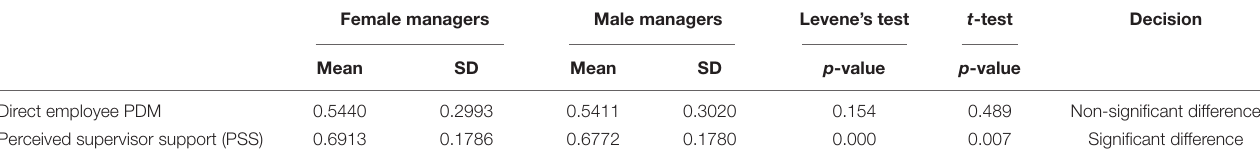
TABLE 3 | Descriptive statistics and hypothesis testing according to the gender of managers.